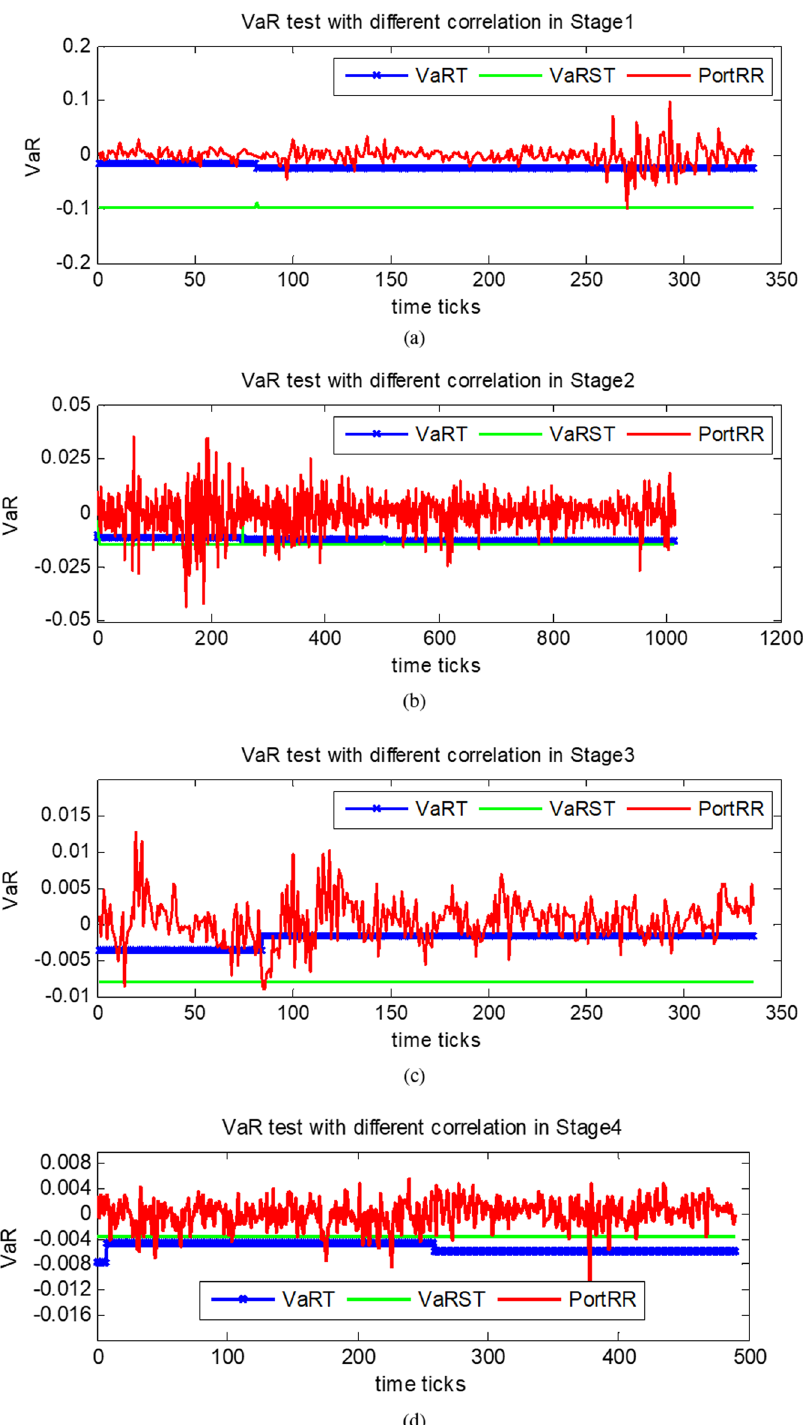
Fig. 7 The comparing performance of VaR in different